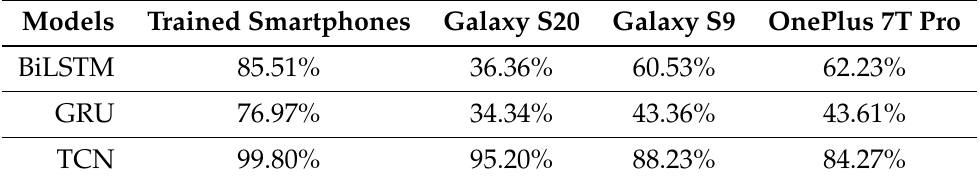
Table 3. Prediction accuracy with the trained and untrained